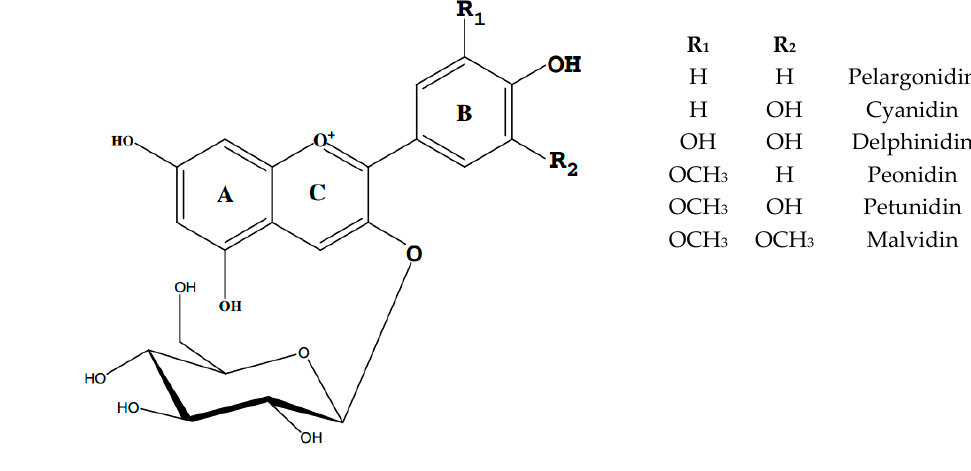
Figure 1. Structure of anthocyanins [5].